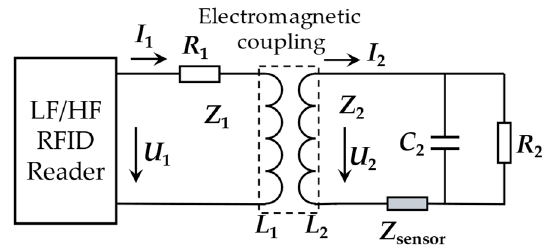
Figure 3. Equivalent circuit of LF/HF RFID tag.